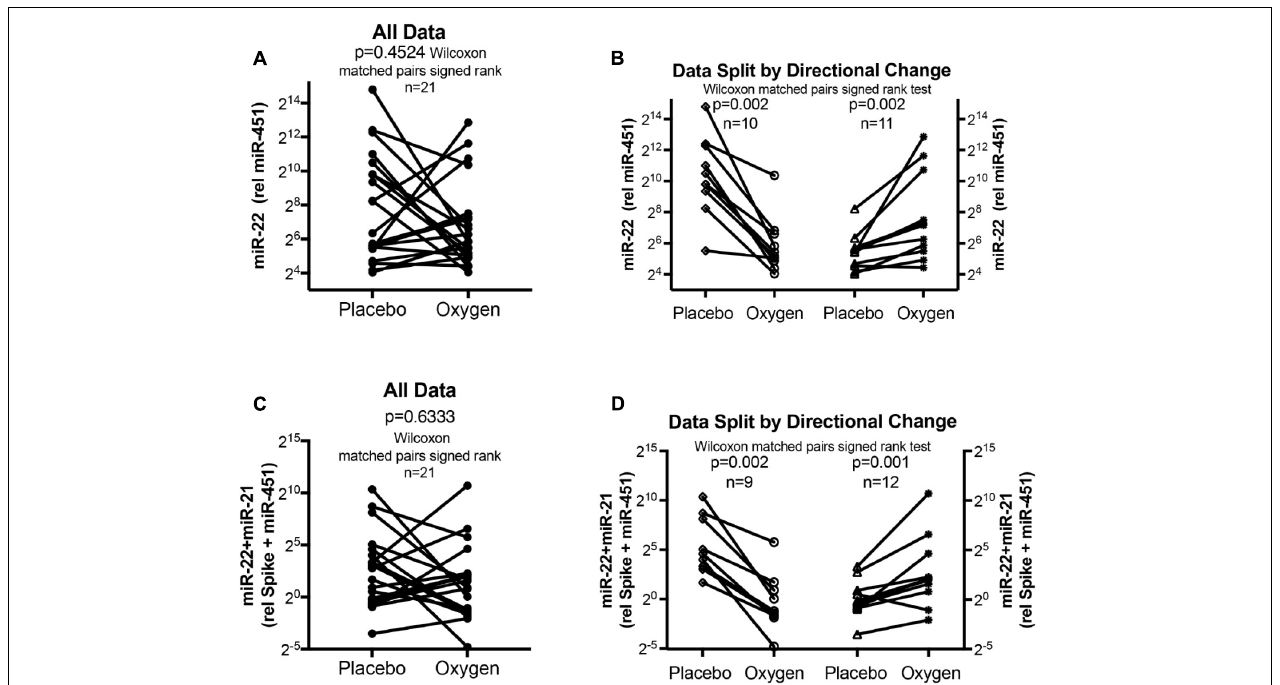
FIGURE 4 | Circulating serum miRNA values in the oxygen intervention study. Symbols and lines graphs show miR-22-3p relative to miR-451a (10,000 × ) values (A,B) , or miR-22-3p + miR-21-5p relative to spike-RNA + miR-451a (10,000 × ) values (C,D) in plasma samples obtained from patients (Schumacher et al., 2014; Ulrich et al., 2015) given placebo (air) or oxygen in a cross-over design. All of the data are plotted in (A,C) ; in (B,D) the data are separated by the directional change in the samples after oxygen intervention. Groups before and after intervention were compared with the Wilcoxon matched pairs signed rank test; p < 0.05 was considered